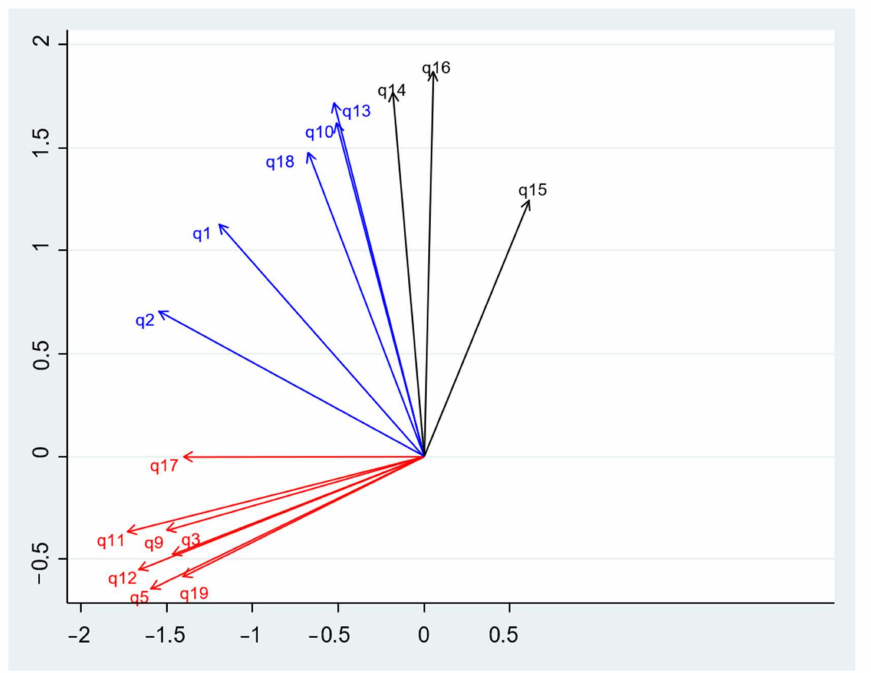
Figure 1. Biplot after factor analysis. Correlations are approximated by the cosine of angles between vectors. Red: Stress; Blue: Coping; Black: